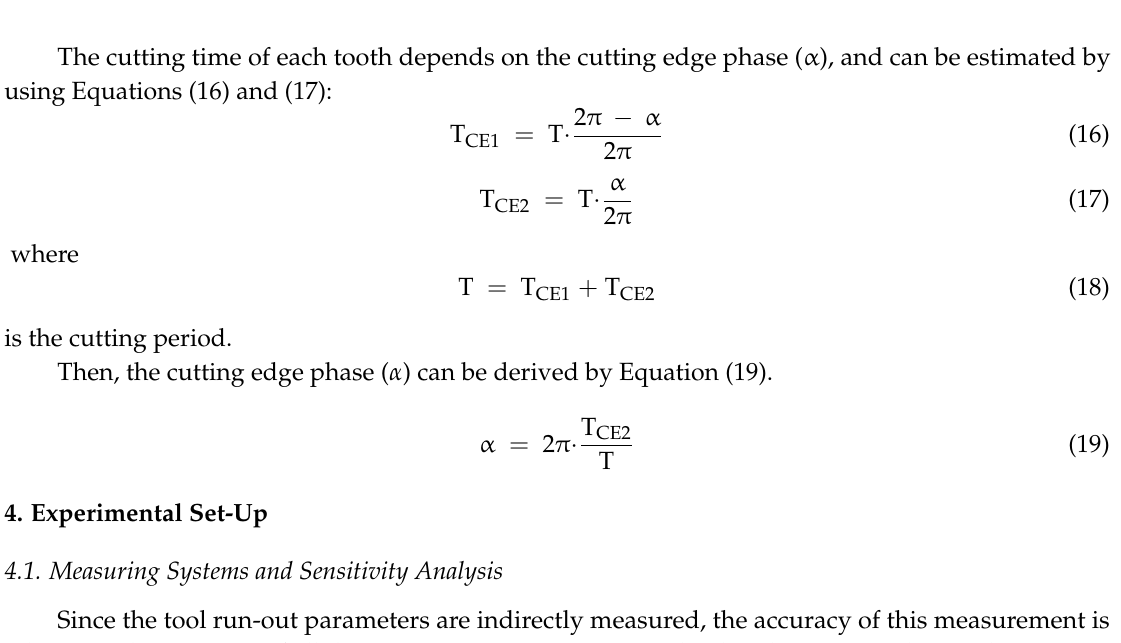
Figure 5. Experimental signal of cutting force for a two-flute micro end mill with run-out.